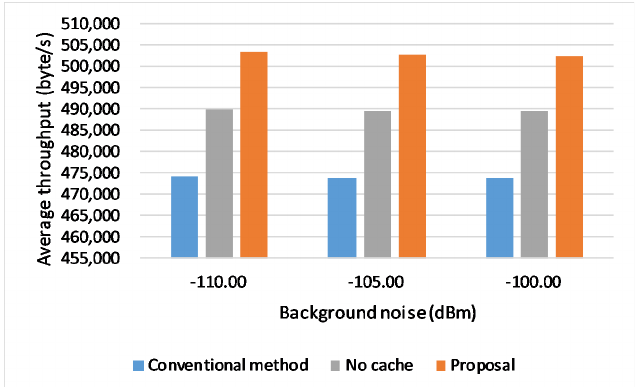
Figure 13. Throughput in different background noise